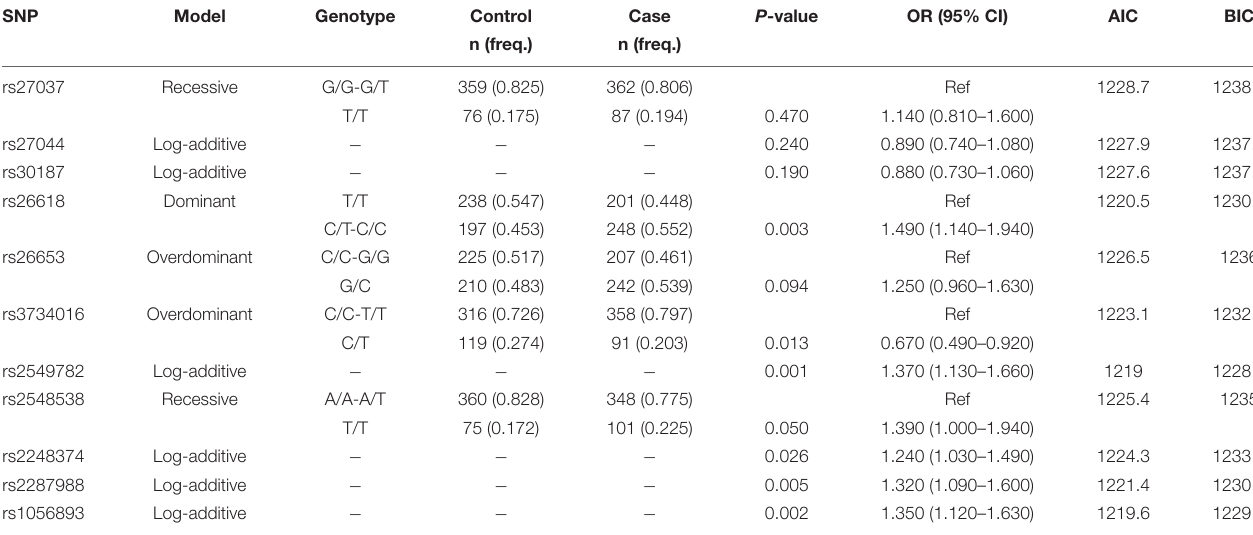
TABLE 3 | The best-fit inheritance models analysis for each SNPs in ERAP1 and ERAP2 gene between the TB and the control groups.